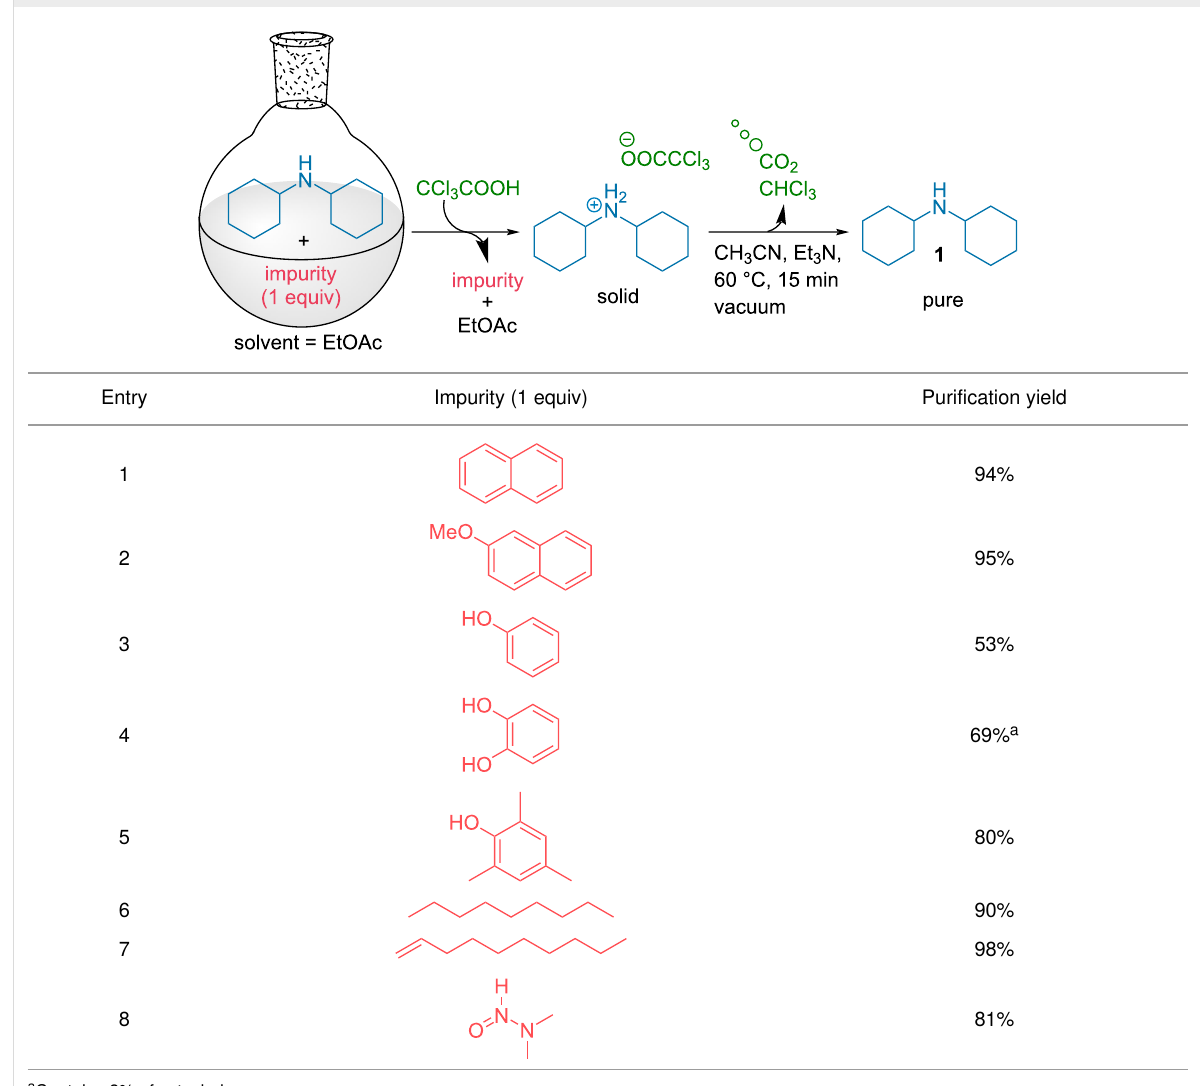
Table 2: Examples of impurities removed from